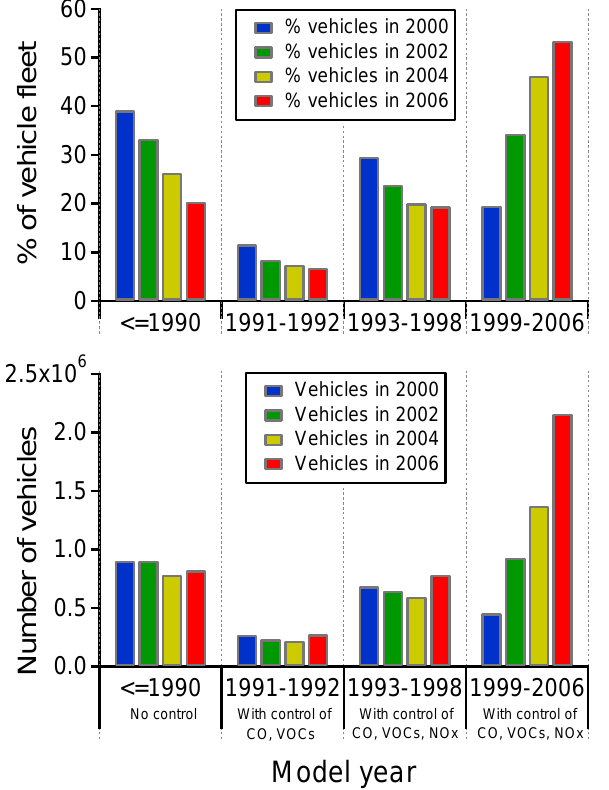
Fig. 5. Upper panel: evolution of the model-year distributions of the gasoline vehicle fleets (in %) from 2000 to 2006. Lower panel: evolution of the size of the gasoline vehicle fleet by model-year in the same period. Data adapted from SMA (2008a).